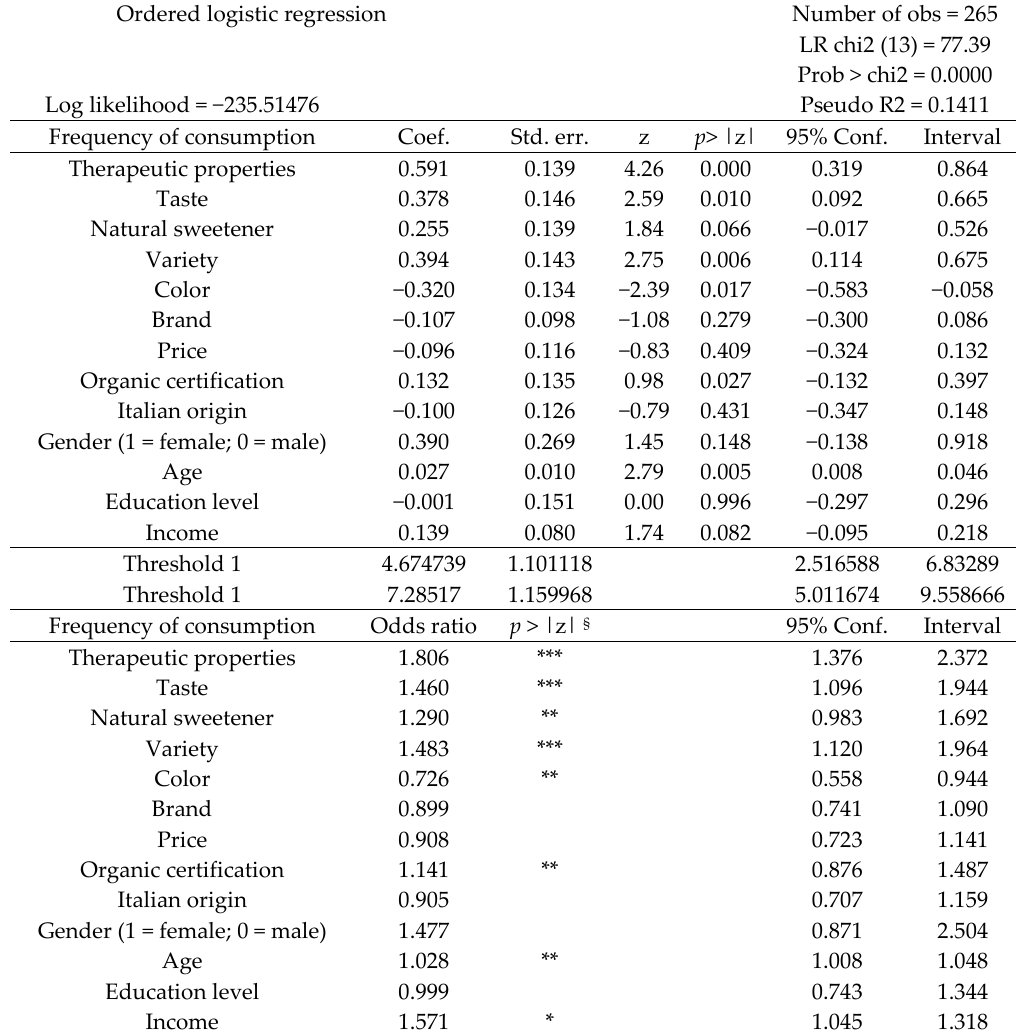
Table 4. Results of the econometric model (ordered logistic regression).